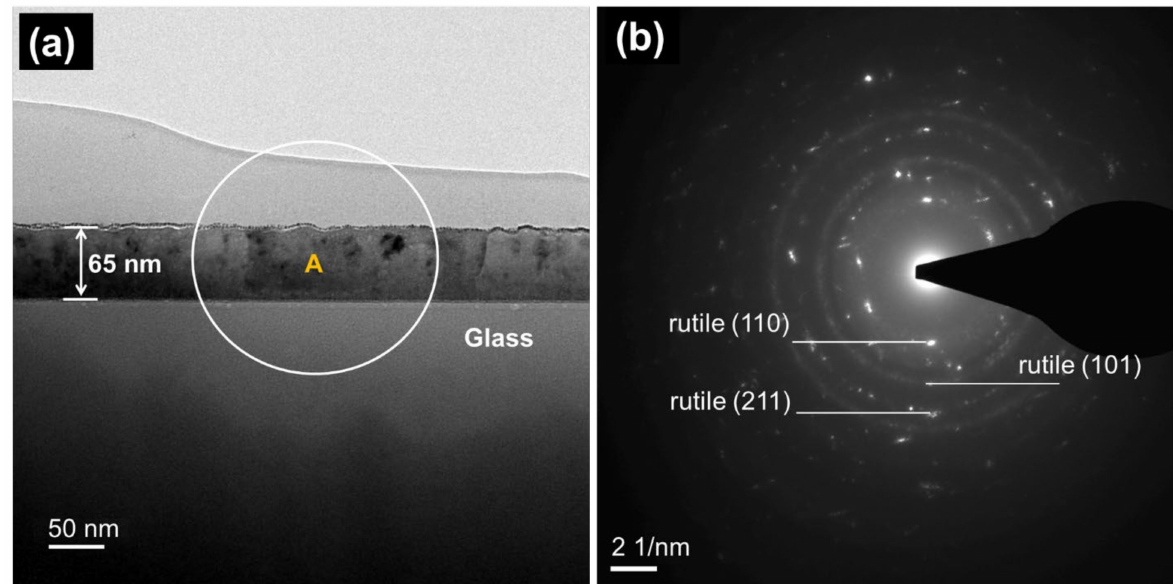
Figure 4. Cross-sectional HR-TEM images of TiO 2 thin-film ( a ) bright-field of the film with a thickness 65 nm. The image (inset A) was selected for electron diffraction analysis, and ( b ) the selective area diffraction pattern of section “A” adjacent to rutile TiO 2